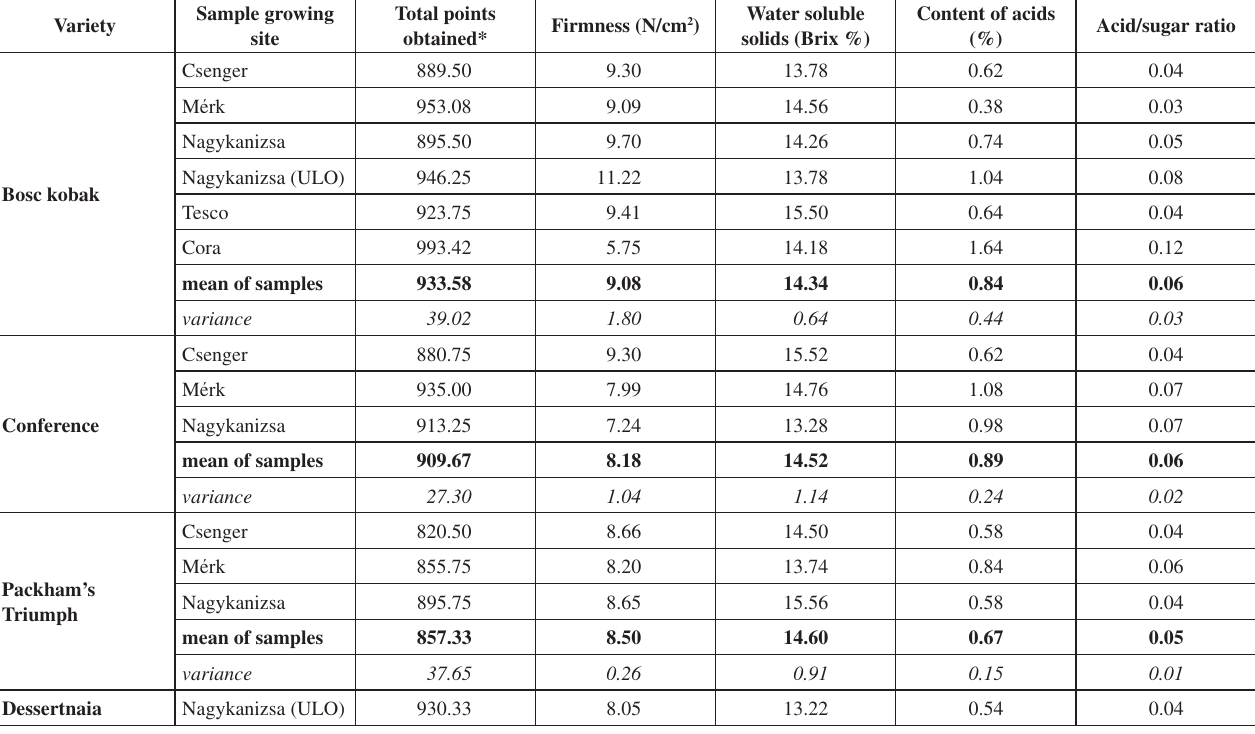
Table 1. Comparison of the results of sensorial tests and measurements obtains in the laboratory regarding the quality of pear varieties. Debrecen, 2012